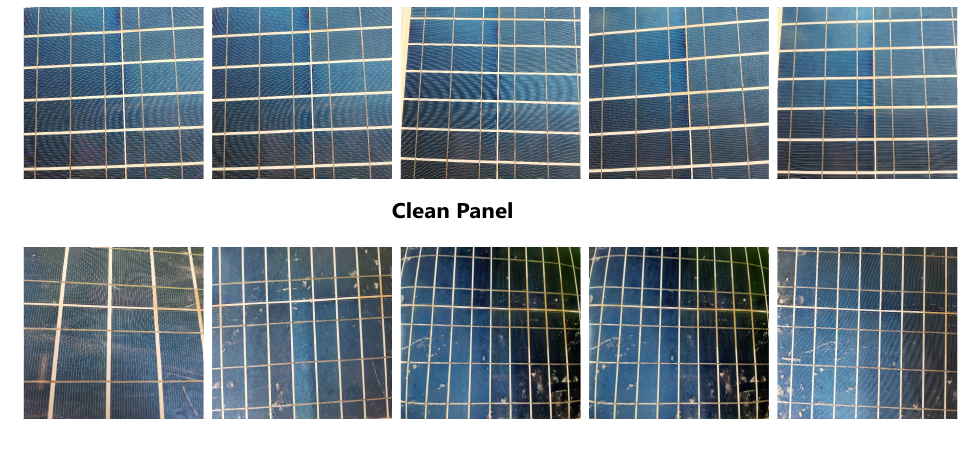
Figure 3. Clean and dirty solar panel images from dataset.